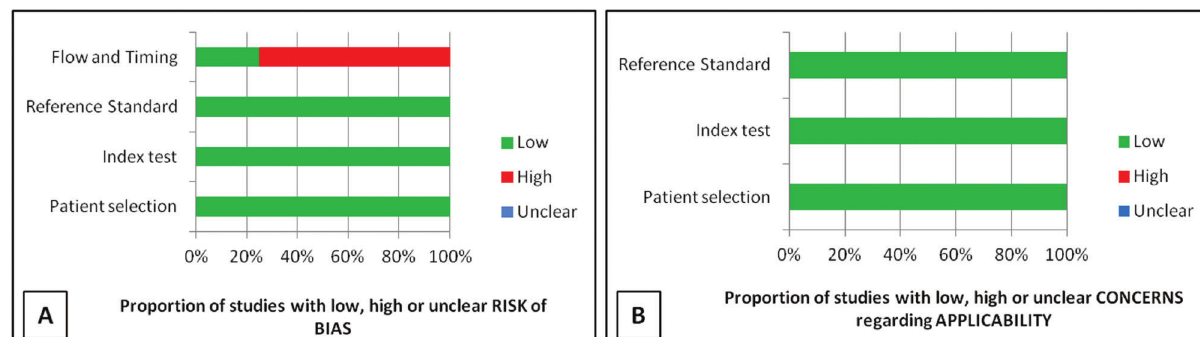
Figure 2 - (A) Proportion of studies with high, low or inconclusive risk bias, showing only a high risk of bias in the flow and timing; (B) Proportion of studies with biases of high, low or non-clear risk applicability. There is a low risk of applicability biases.